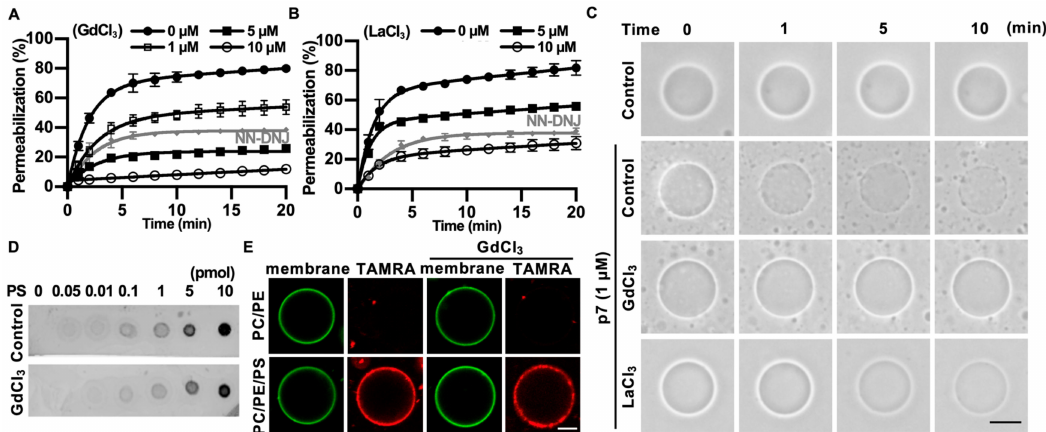
Figure 4. Inhibitory e ff ects of GdCl 3 or LaCl 3 on p7-induced membrane permeabilization. ( A , B ) CF-encapsulated LUVs composed of PC:PE:PS, 3:1:1 (mol / mol), were incubated with 1 µ M p7 and the indicated concentration of GdCl 3 ( A ) or LaCl 3 ( B ). Fluorescent signals were recorded by spectrophotometry. NN-DNJ (10 µ M) was used as a positive control. ( C ) p7 (1 µ M) was used for GUVs composed of PC:PE:PS, 3:1:1, in the presence of 10 µ M GdCl 3 or LaCl 3 and incubated with